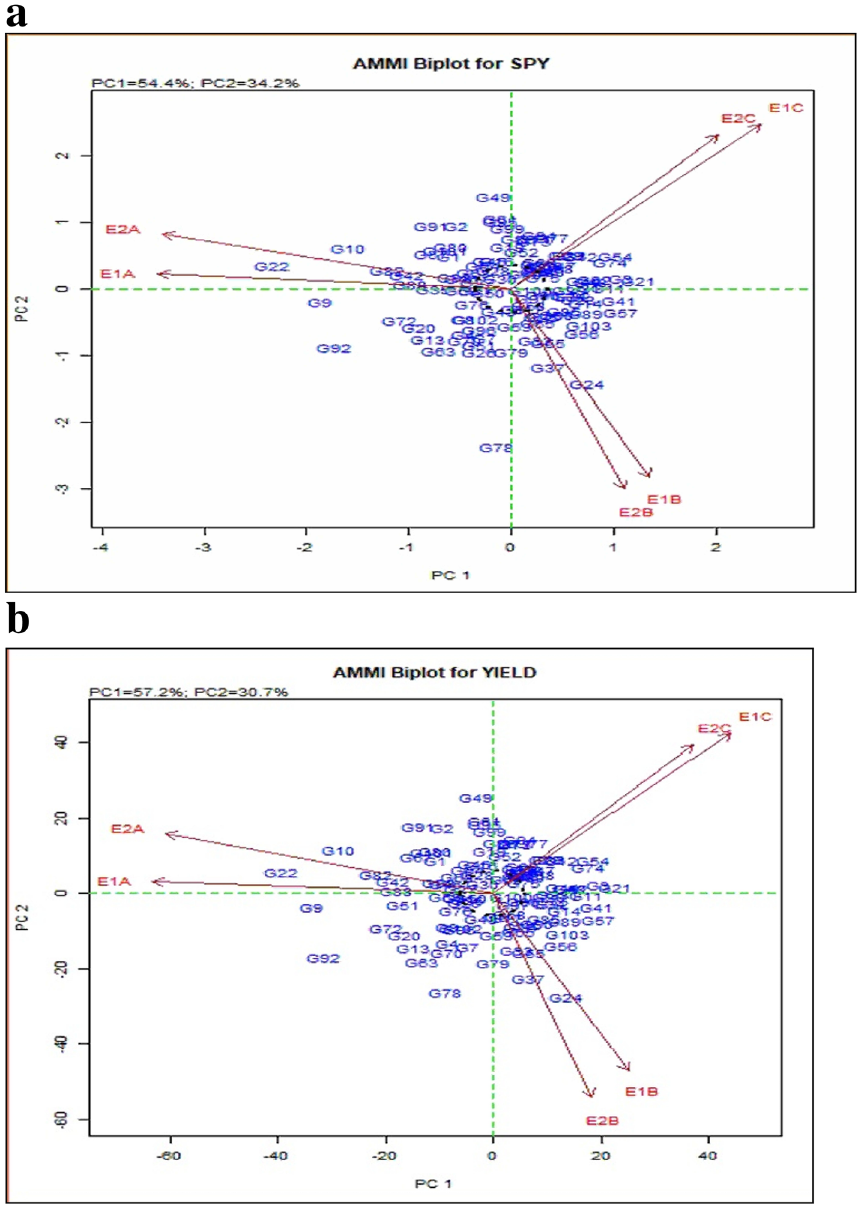
Figure 3. AMMI biplot for the primary component of interaction (PC1) and mean or main effect of rice genotypes in different environments showing relationship between environments and tested genotypes (For SPY ( a ), Yield ( b )). GGE biplot for the primary component of interaction (PC1) and mean or main effect of rice genotypes in different environments showing relationship between environments and tested genotypes (For SPY ( c ), Yield ( d